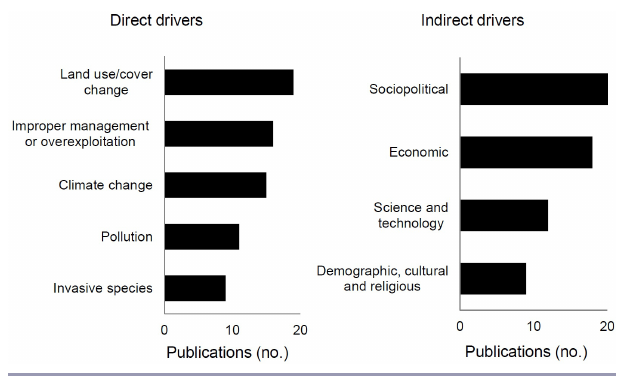
Fig. 4 . Number of publications dealing with different drivers of cultural ecosystem service change: (a) direct drivers, and (b) indirect drivers. Some publications discussed no drivers or multiple drivers.